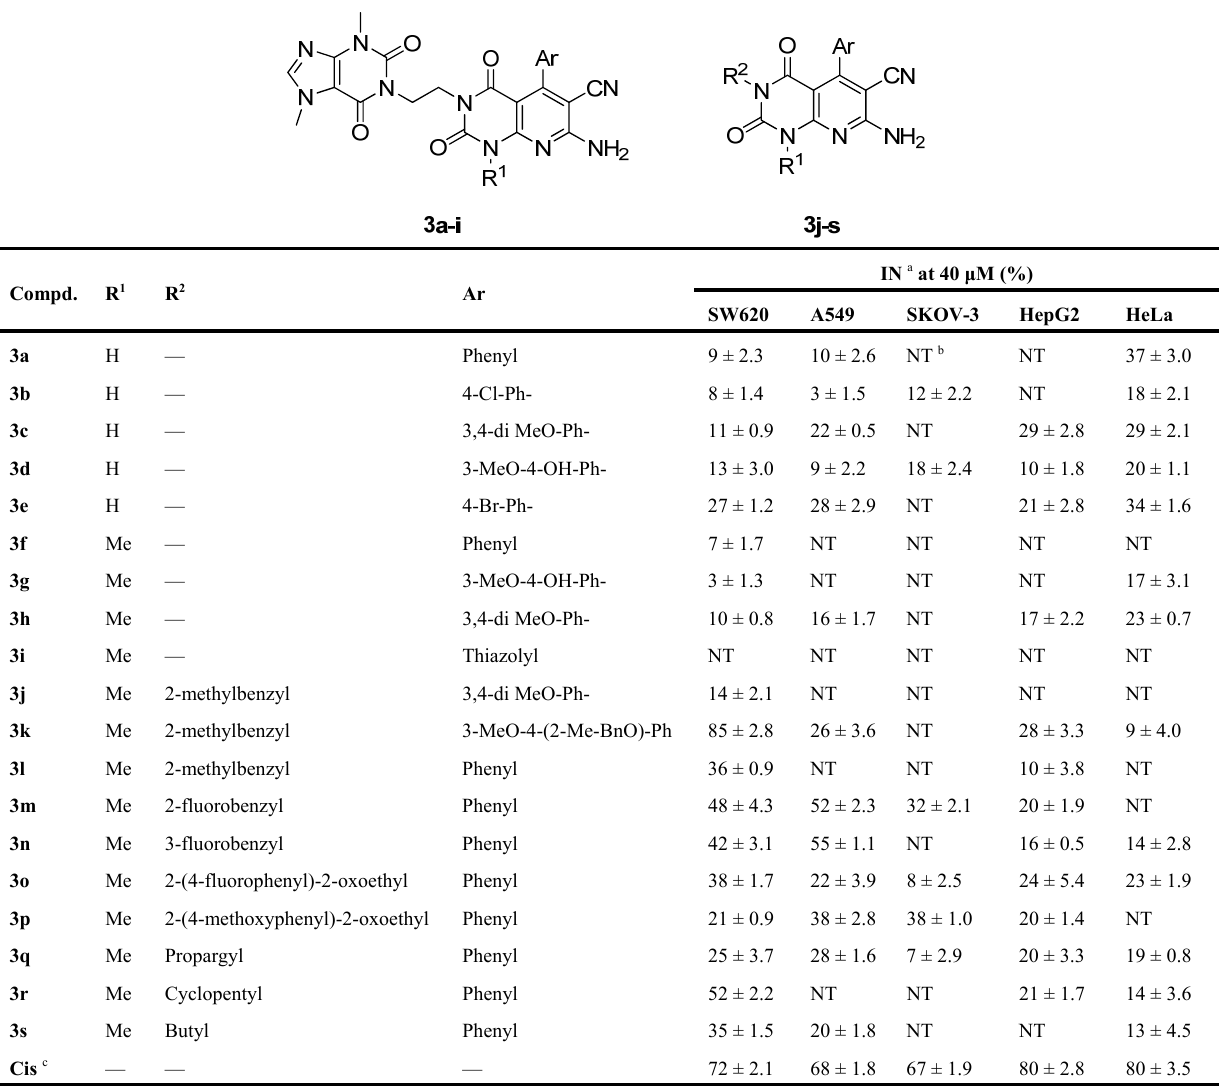
a IN = inhibition, measured 48 h after treatment with compounds 3a–s (40 μ M). Results are given in concentrations of 40 μ M after continuous exposure of 48 h and show means ± SEM values of three- )()( SODCOD  ; b NT denotes not tested; c Cis denotes independent experiments. IR = )( COD